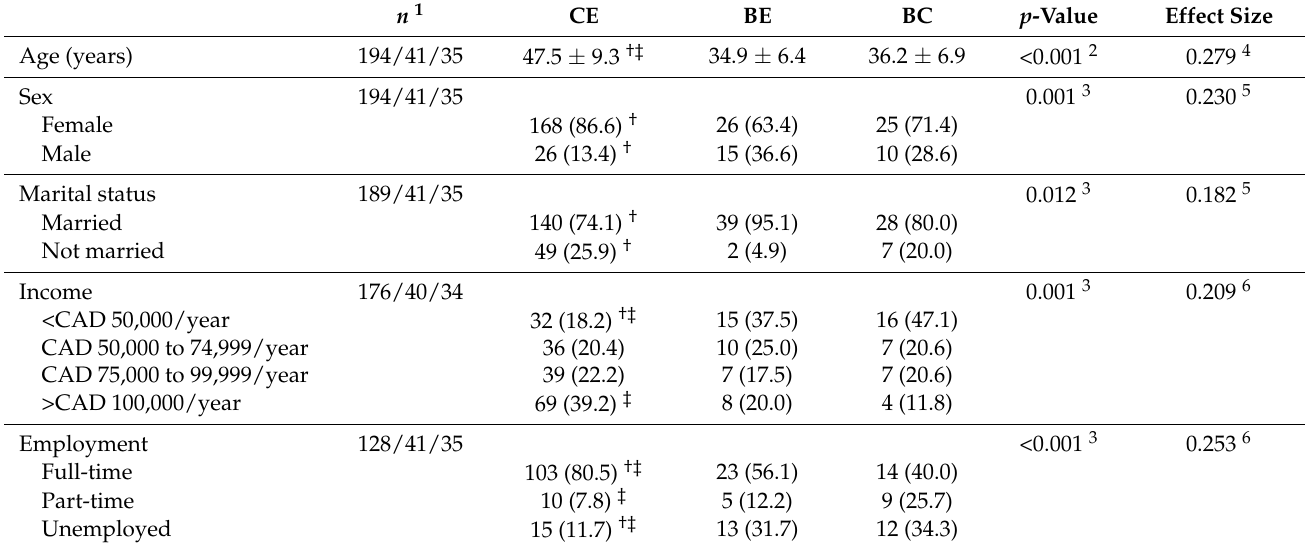
Table 4. Demographic data compared among groups. Data expressed as frequency counts (percent- age), except for age, expressed as mean ± standard deviation.